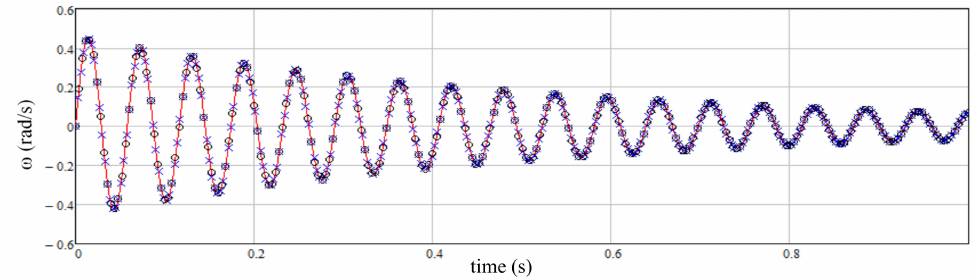
Figure 9. Speed dependencies: __ model with distributed parameters; ooo model of a two-mass system using the Caputo–Fabrizio operator to describe the fractional order derivative in the model of the elastic moment at α = 0.984; xxx —speed calculation, according to the (12) when α =